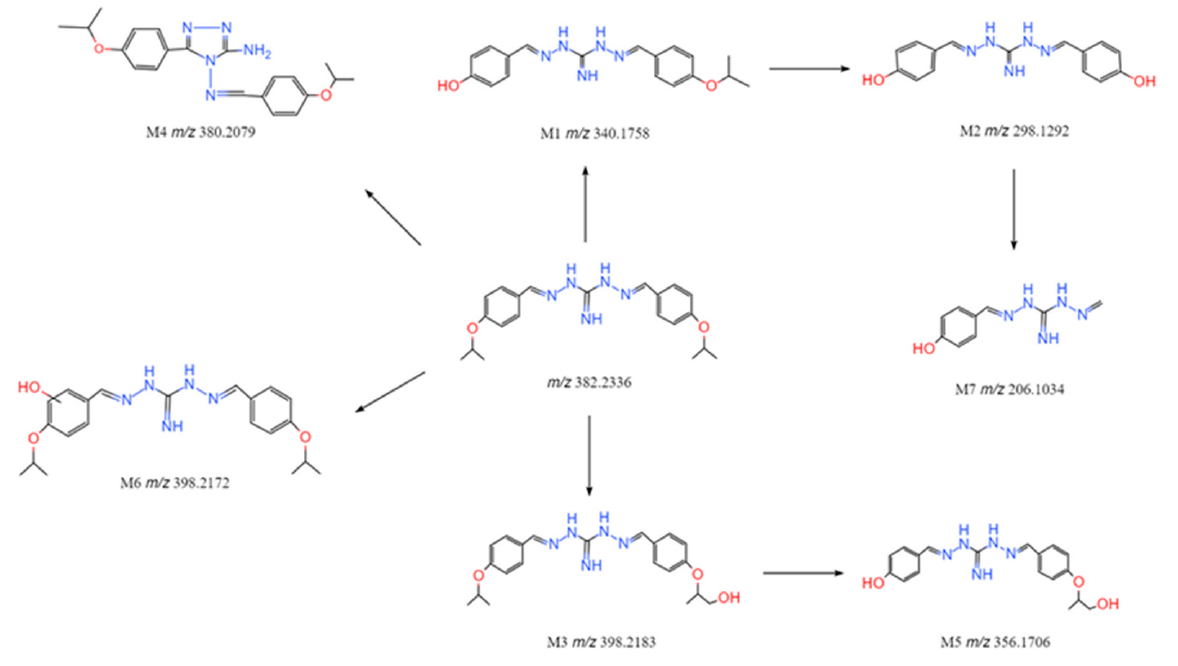
Figure 6. Proposed in vitro metabolic pathways of IBG after exposure to rat liver microsomes.